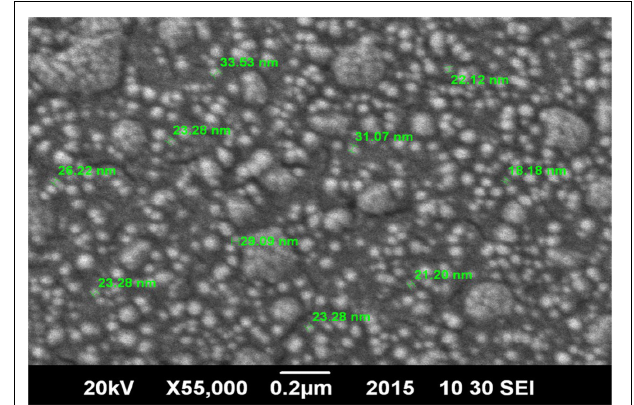
FIGURE 1 | Scanning Electron Microscope (SEM) micrographs. Morphological evaluation of chitosan nano-particles (CSNPs) by scanning electron microscope (SEM) micrographs at 55000 × .